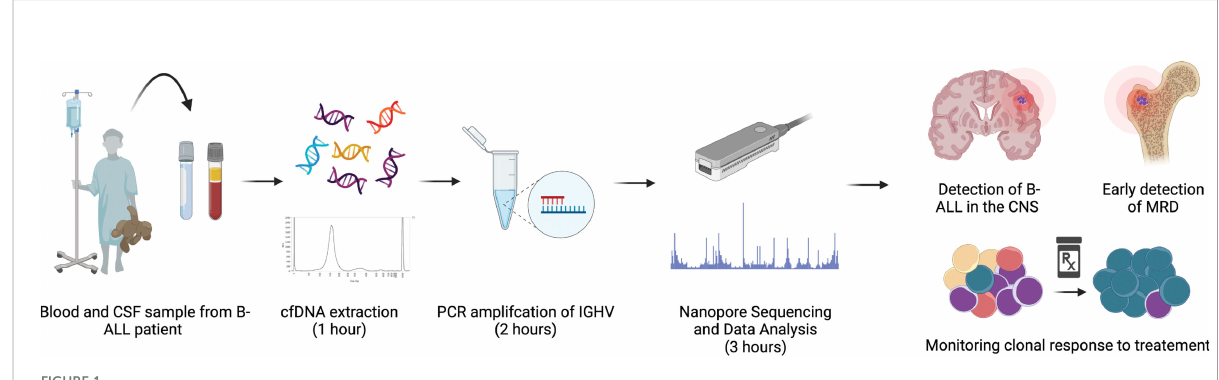
FIGURE 1 Work fl ow of IGHV sequencing. Diagrammatical overview of work fl ow and time input required for sequencing, from patient sample collection to read